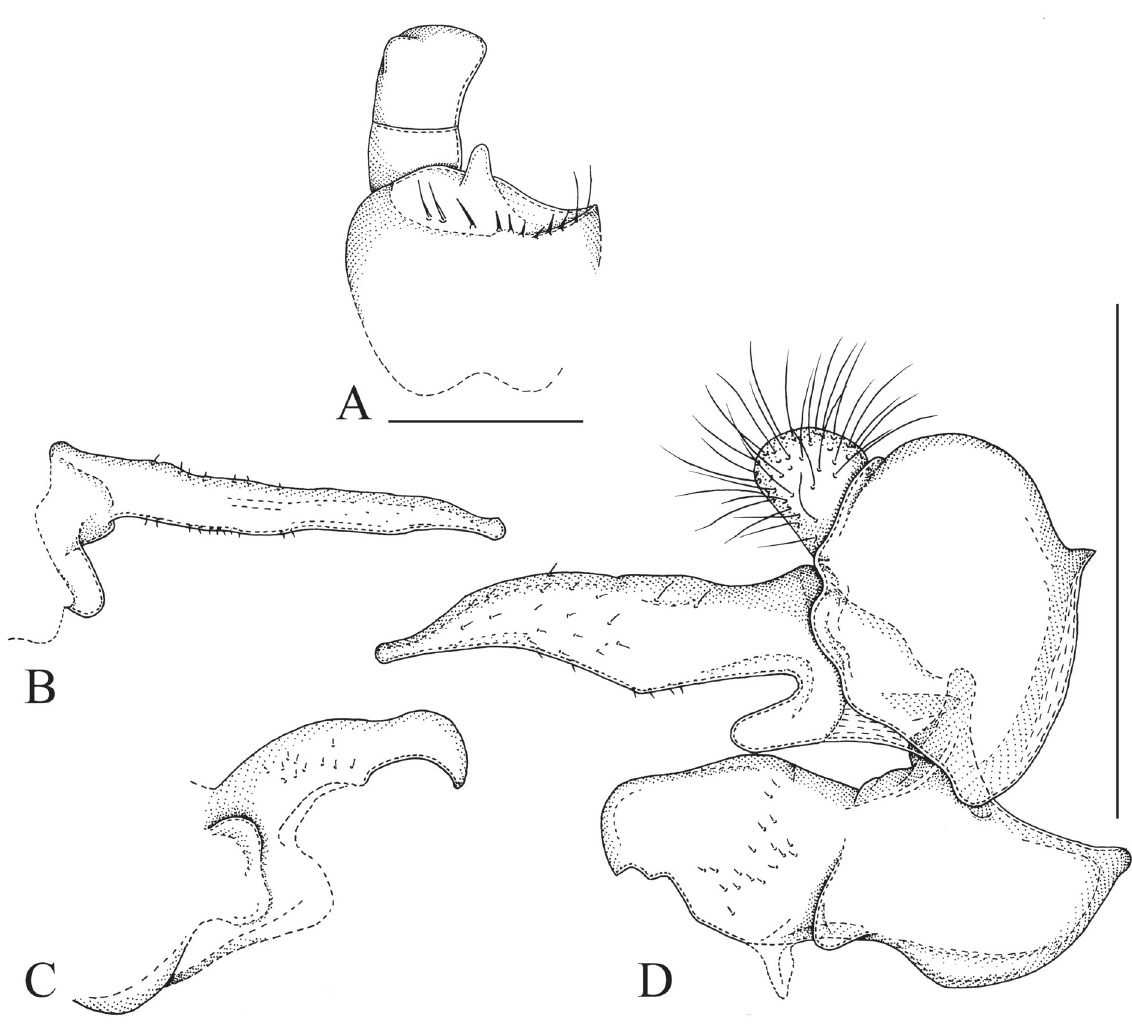
Fig. 58. Sphegina (Asiosphegina) lucida sp. nov., holotype, ♂ . A . Sterna IV, VI and VII, ventral view. B . Left surstylus, lateral view. C . Left superior lobe with associated parts, lateral view. D . Genitalia, right side, lateral view. Scale bars = 0.5